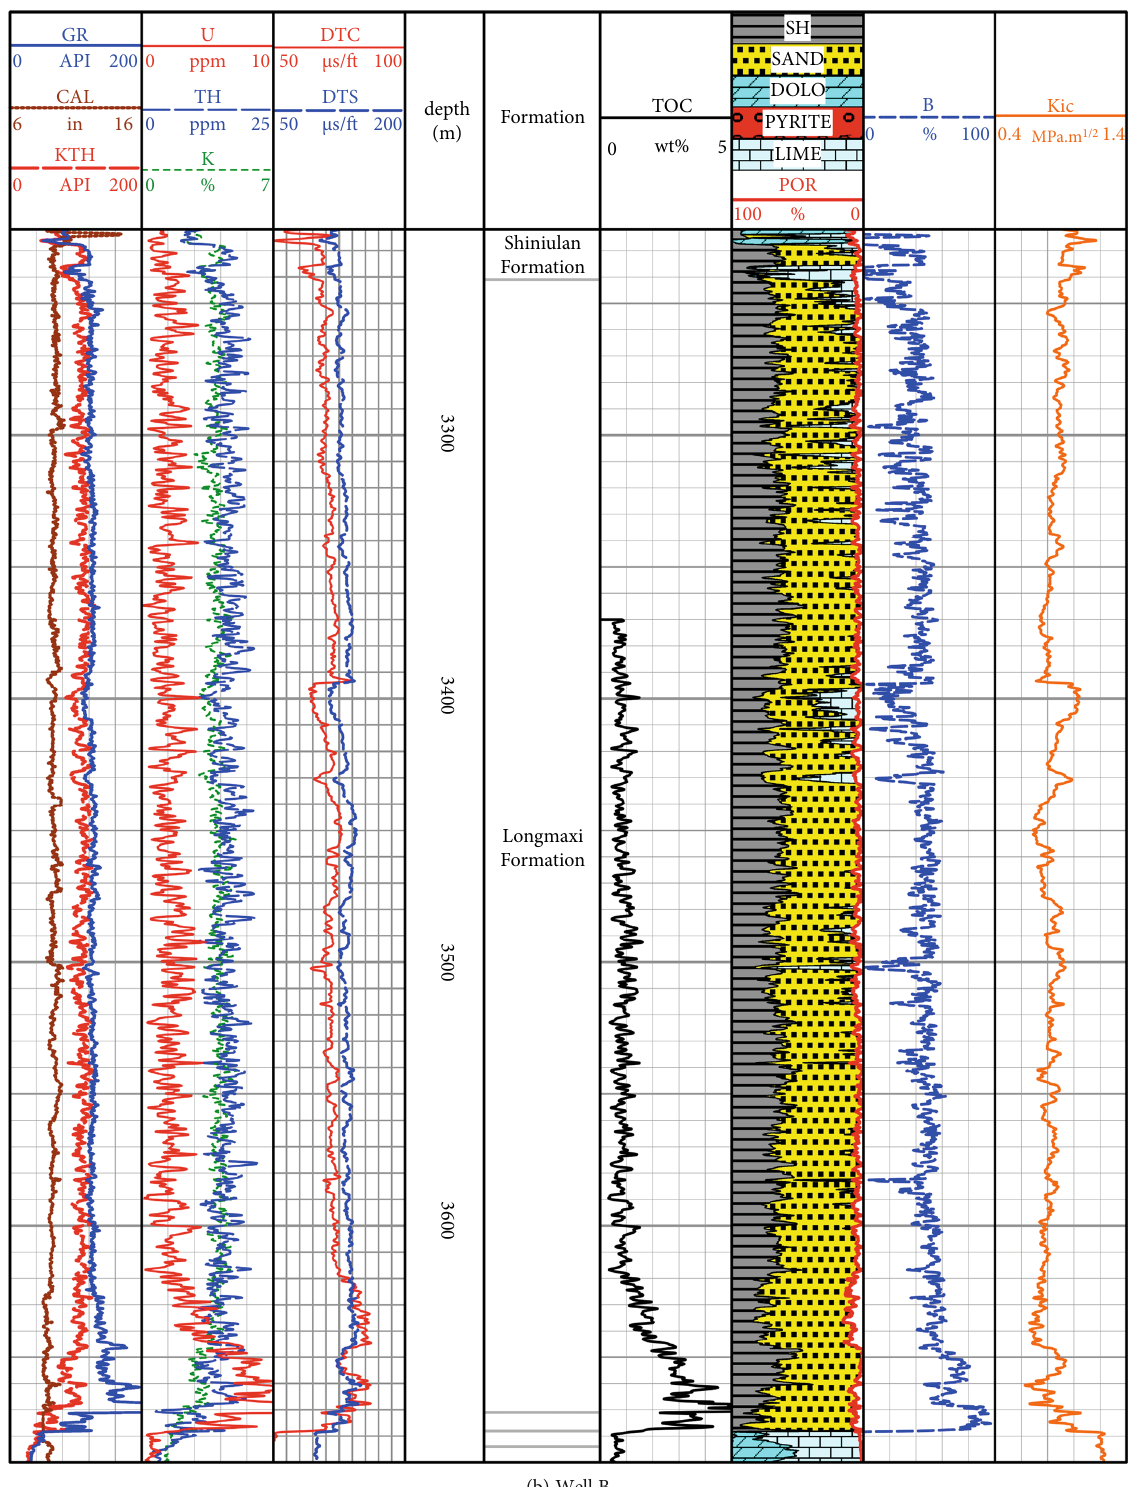
Figure 10: The logging pro fi le of the predicted fracture toughness of shales in the study